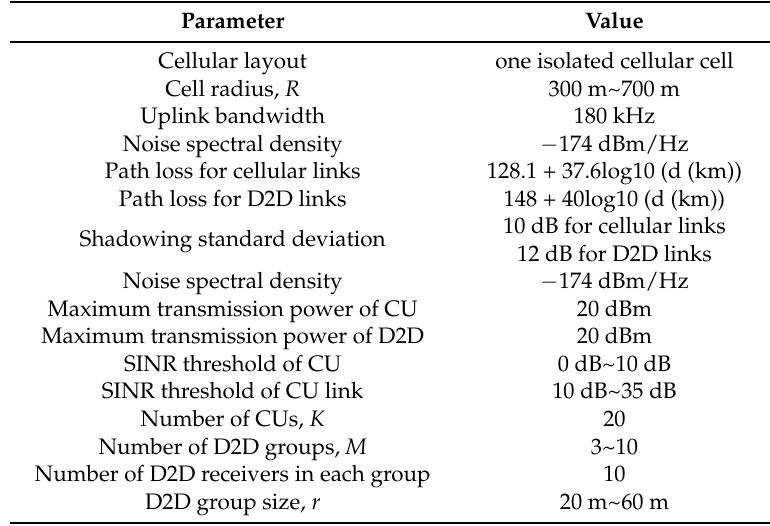
Table 1. Main Simulation